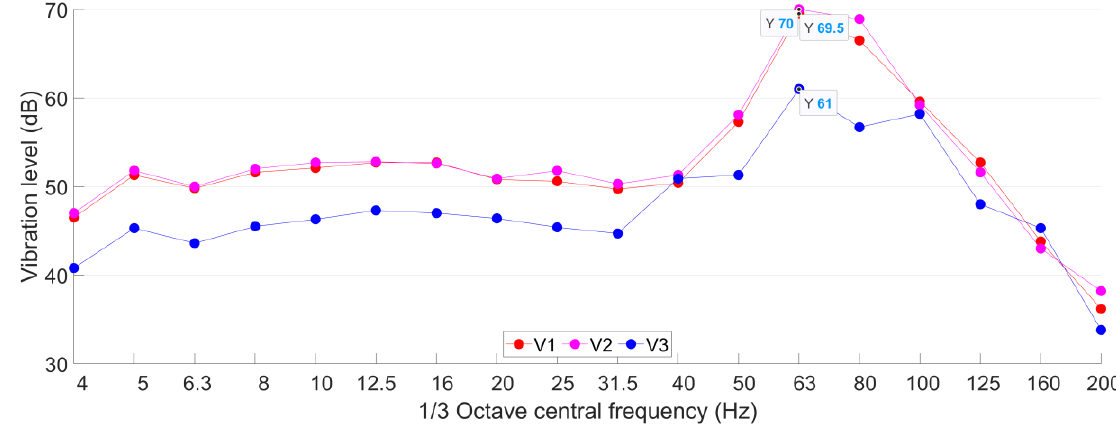
Figure 22. The 1/3 octave frequency division vibration acceleration levels in the cinema.